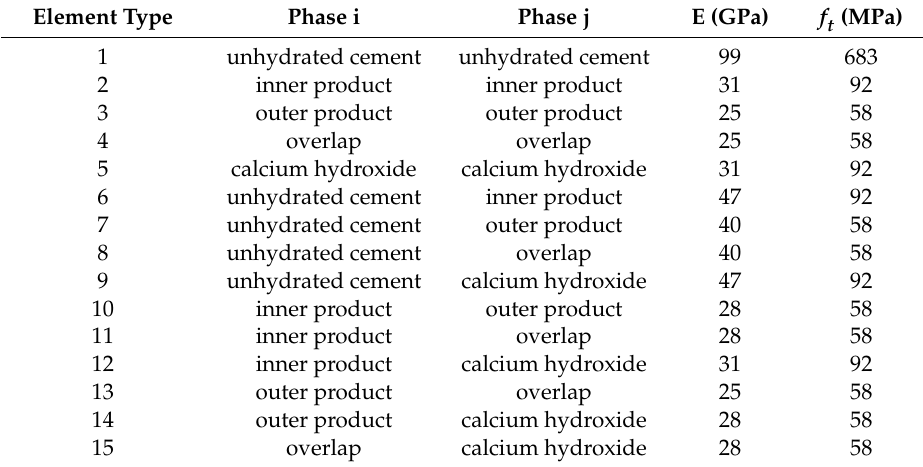
Table 2. Mechanical properties of di ff erent types of lattice elements used in the analysis. Elastic moduli (E) are taken from nanoindentation measurements [79], while tensile strengths ( f t ) are taken from inverse analyses performed in [81]. Note that, in [81], calcium hydroxide and overlap phases were not considered. Herein, calcium hydroxide (CH) is taken to have the same mechanical properties as the inner product [82], while the overlap is taken to be the same as the outer hydration product.